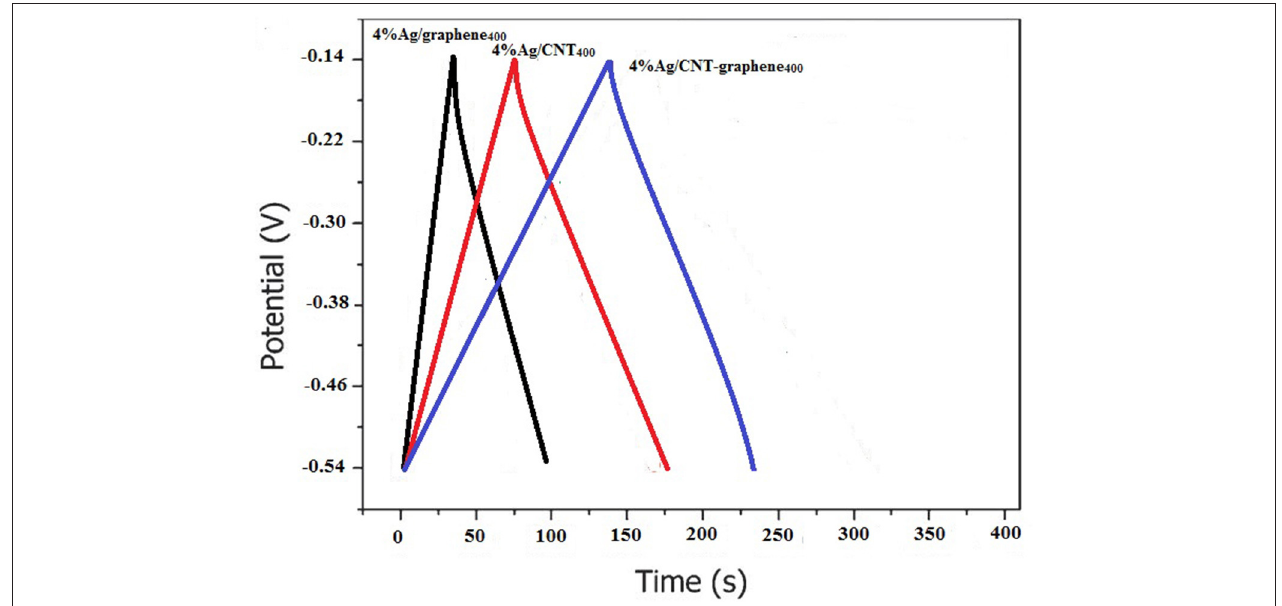
FIGURE 11 | The galvanostatic charge–discharge curves of 4%Ag/graphene 400 , 4%Ag/CNT 400 and 4%Ag/CNT-graphene 400 electrodes during current density of 1.0A g − 1 in 6.0M KOH electrolytes.